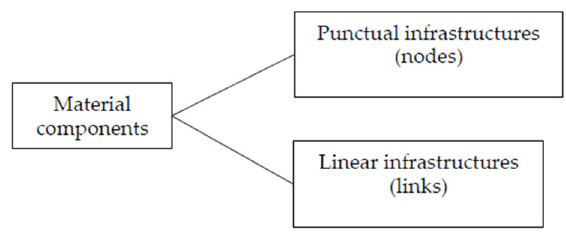
Figure 5. Material